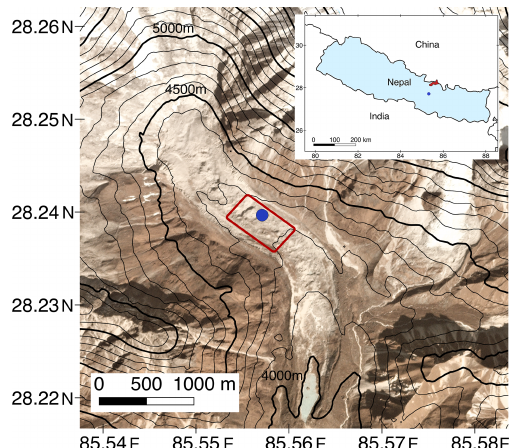
Figure 1. Lirung Glacier with the MicroHH domain (red contour) and the location of the AWS (blue point). The background image is a Planet image from 9 December 2018 (Planet Team, 2017). The inset shows the Langtang catchment (red) and its location in